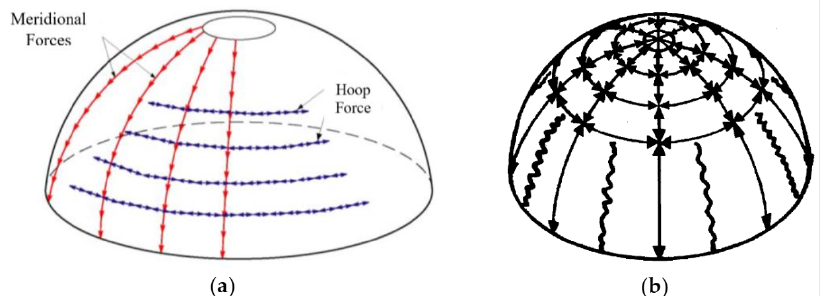
Figure 1. ( a ) Force type of dome structures; ( b ) meridional and hoop load paths for a masonry dome cracked in its lower sections only. Adapted from “Statics of Historic Masonry Constructions” written by Mario Como [6] and “The Digital Workflow of Parametric Structural Design - Developing Grid Shells in a Nordic Climate” written by Marie Eliassen and Åshild Huseby